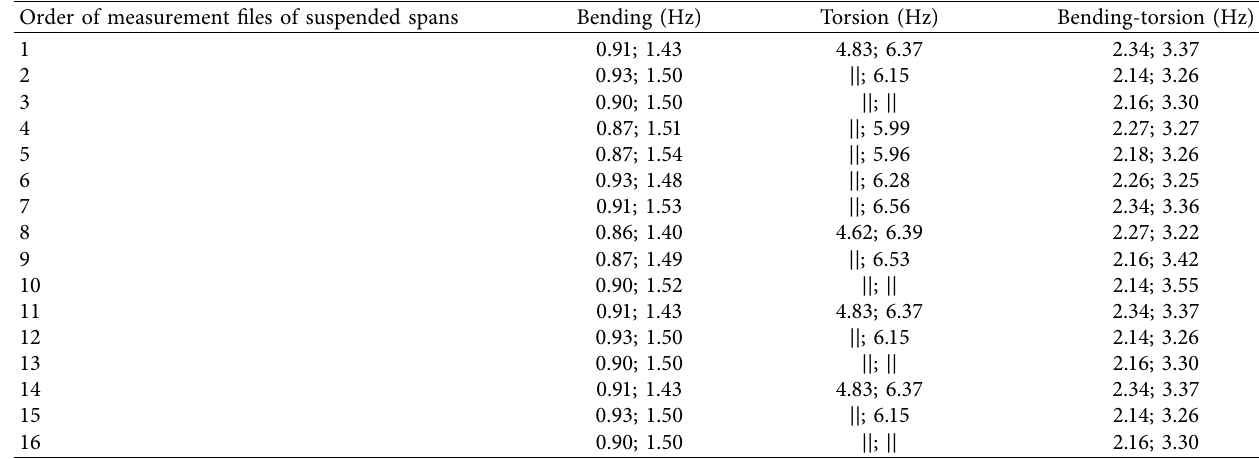
Table 8: Statistics of frequencies of Phu My cable-stayed bridge (obtained from LAM). Order of measurement files of suspended spans